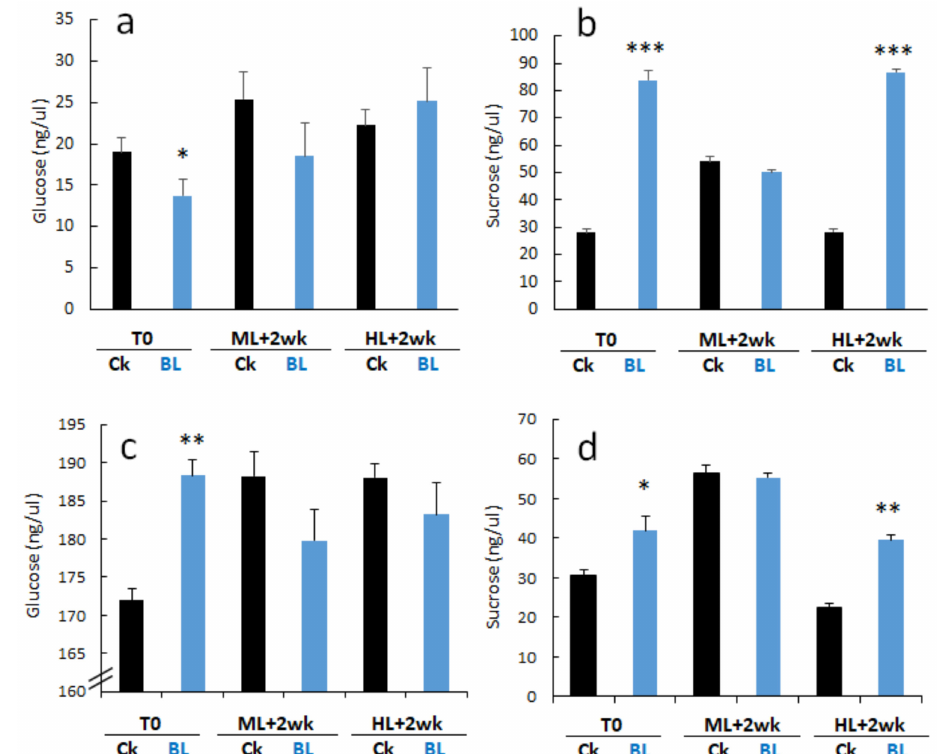
Figure 7. Blue light acclimation altered glucose and sucrose accumulation in moth orchids. ( a , b ) Young seedlings, ( c , d ) mature 2.5” potted plants. ( a , c ) Glucose content, ( b , d ) sucrose content. Statistical analyses are as described in the Figure 3 legend. Error bars represent the standard error of the mean ( n = 3). *, p < 0.05; **, p < 0.01; ***, p <